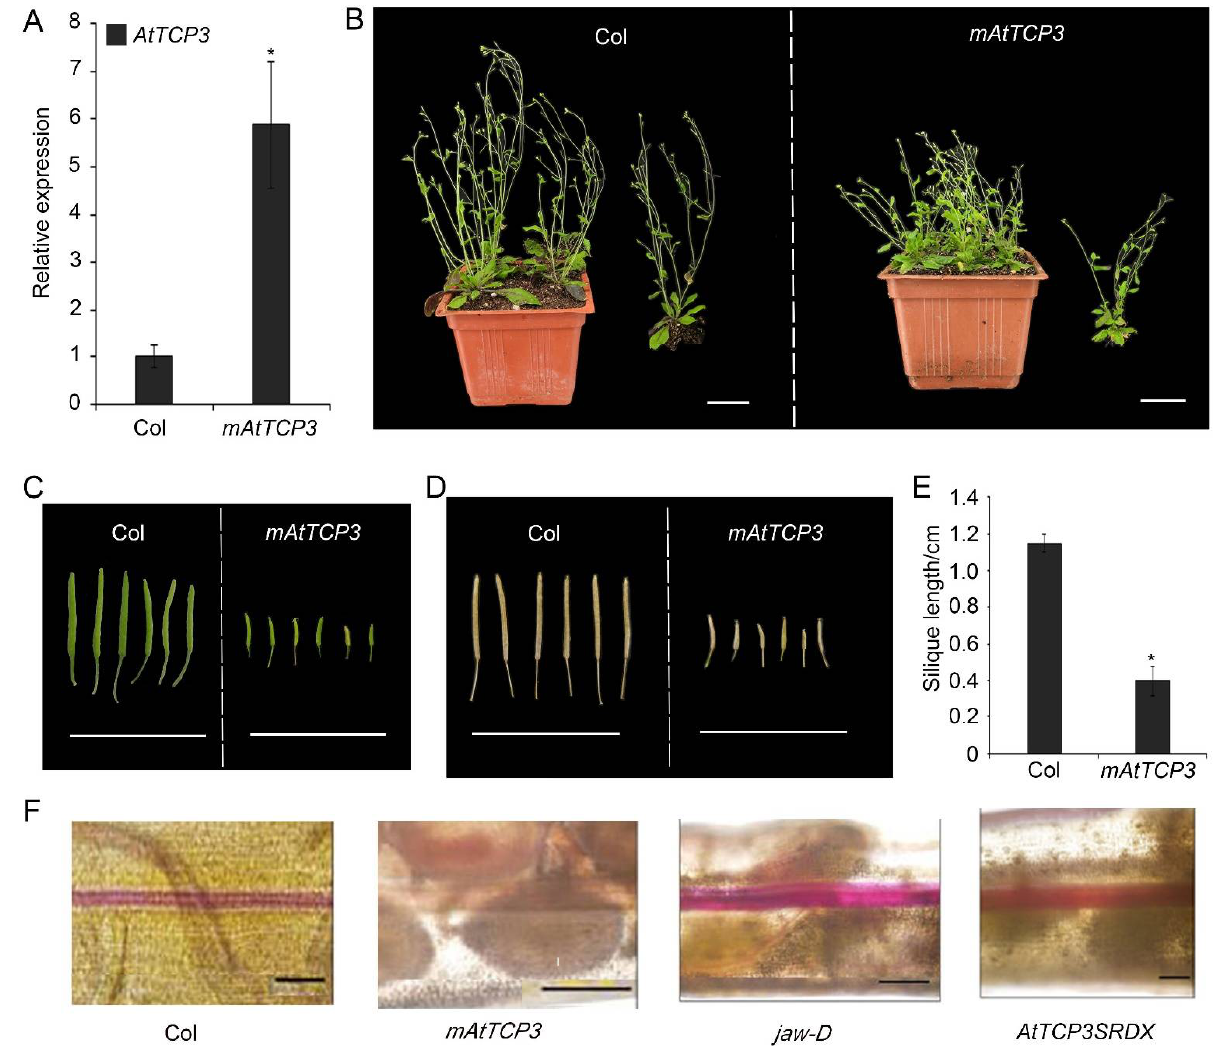
Figure 3. Silique phenotype and lignification of repla in mAtTCP3 transgenic plants. ( A ) Real-time PCR showing expression levels of AtTCP3 in p35S::mAtTCP3 siliques. ( B ) Phenotype of the wild-type and p35S::mAtTCP3 plants at reproductive stage. ( C ) Green siliques (stage 17) of the wild-type (left) and p35S::mAtTCP3 (right) plants. ( D ) Mature siliques (stage 18) of the wild-type (left) and p35S::mAtTCP3 (right) plants. ( E ) Graph showing silique length of the wild-type (Col) and mAtTCP3 ( p35S::mAtTCP3 ) plants. ( F ) Phloroglucinol staining showing lignin-specific signals in the siliques of Col, jaw-D, mAtTCP3 , and AtTCP3SRDX plants. mAtTCP3 , p35S::mAtTCP3 lines. AtTCP3SRDX , pAtTCP3:: AtTCP3SRDX . The relative transcript level of each gene was normalized to Actin cDNA